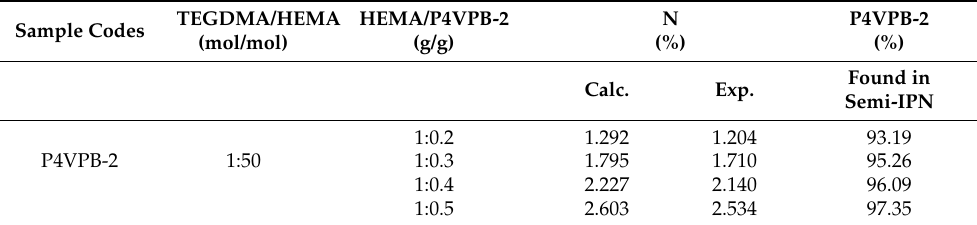
Table 2. Influence of the amount of P4VPB-2 on nitrogen content. Sample